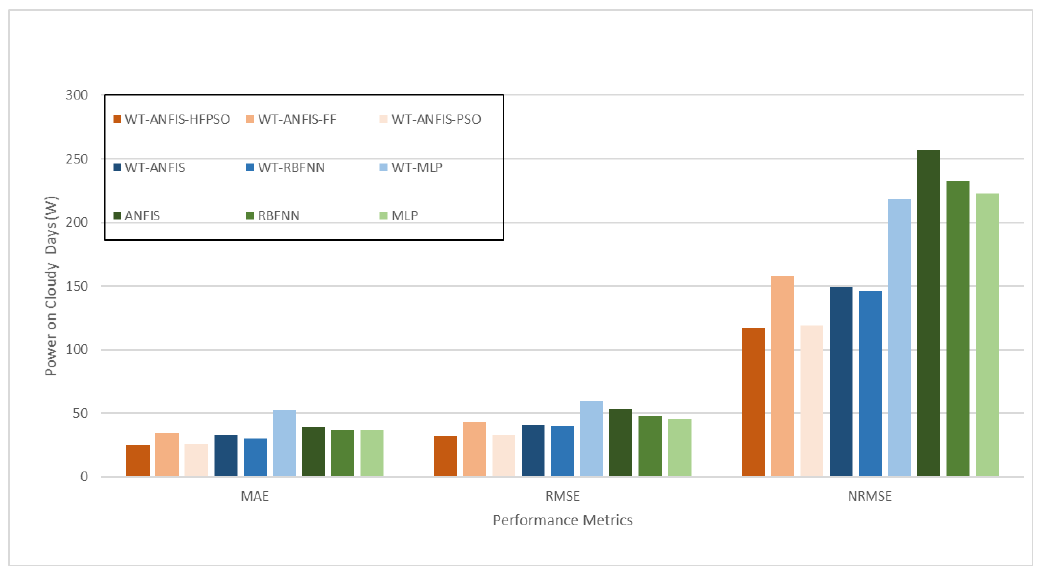
Figure 12. Comparison of forecasting models in terms of the MAE, RMSE and RMSE on cloudy days.